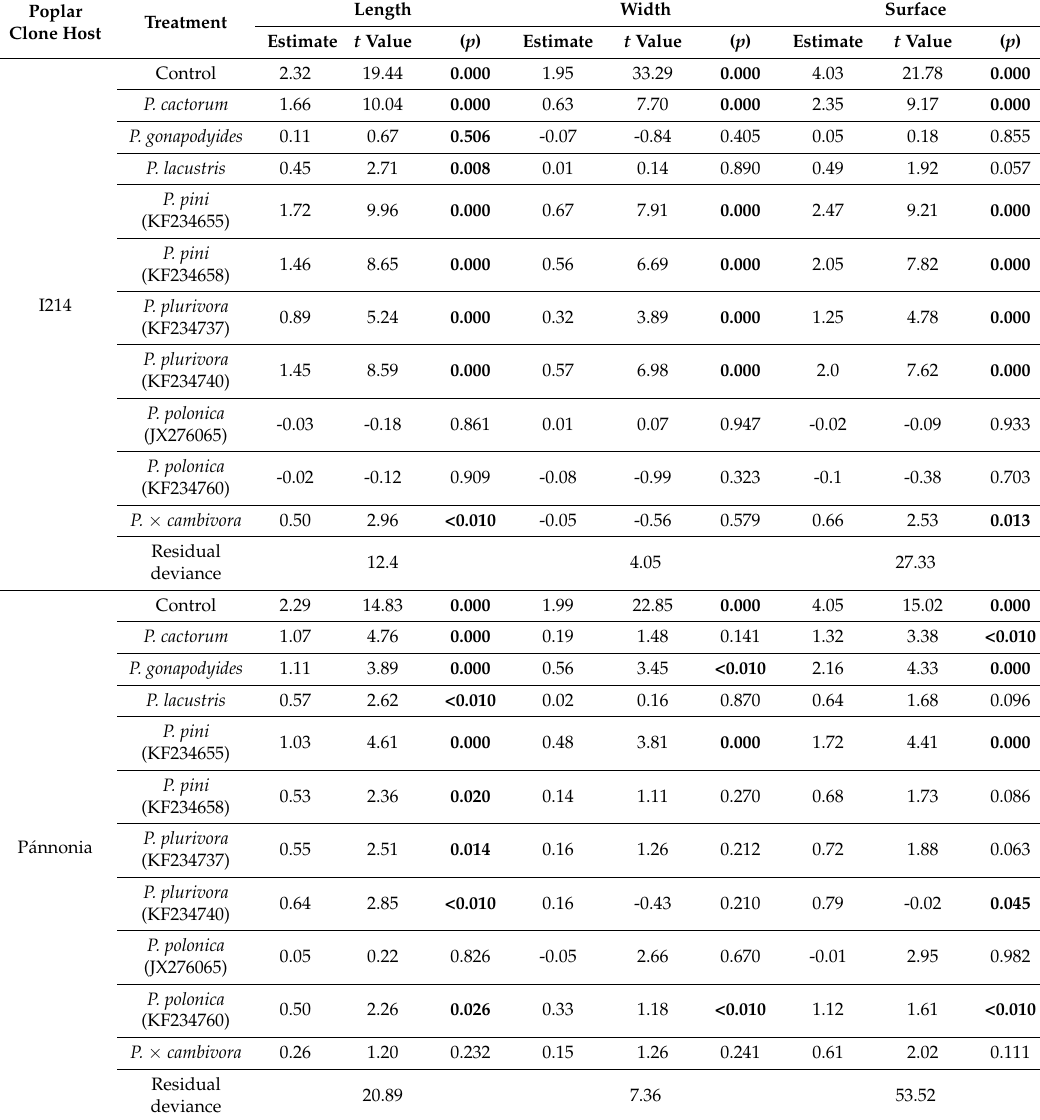
Table 4. Estimates, t values, p values, and Residual deviances from GLM for tested parameters in the underbark inoculation trial with poplars. In clone I-214, degrees of freedom (df) for Residual deviance was 114; in clone P á nnonia df for Residual, deviance was 109. Significant effects are marked in bold